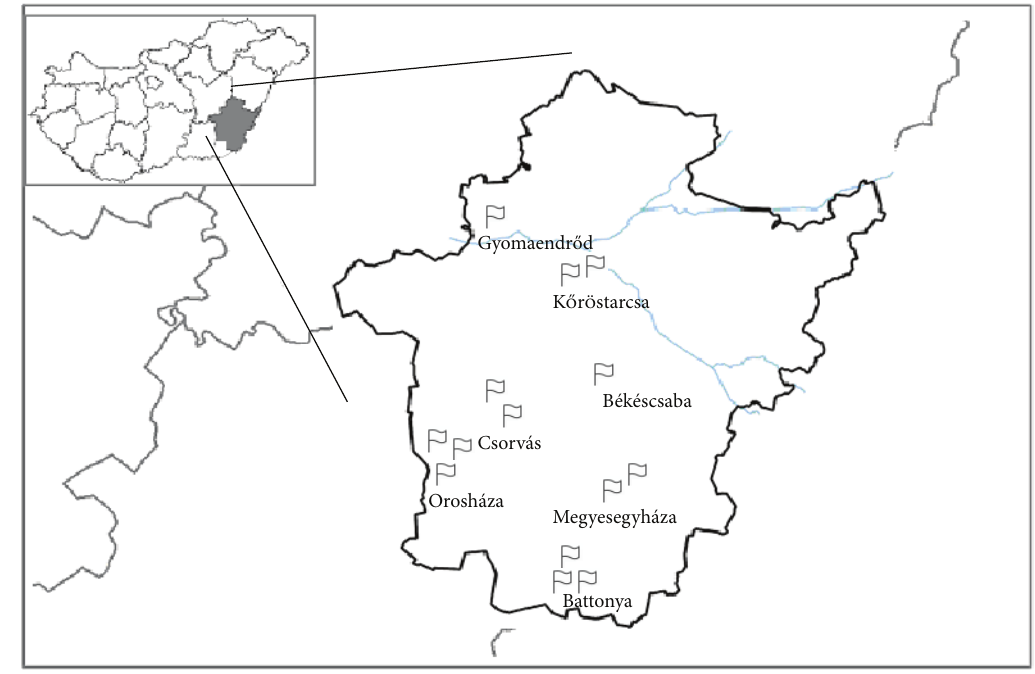
Figure 3: Surface and ground water sampling sites in B´ek´es county (Hungary)